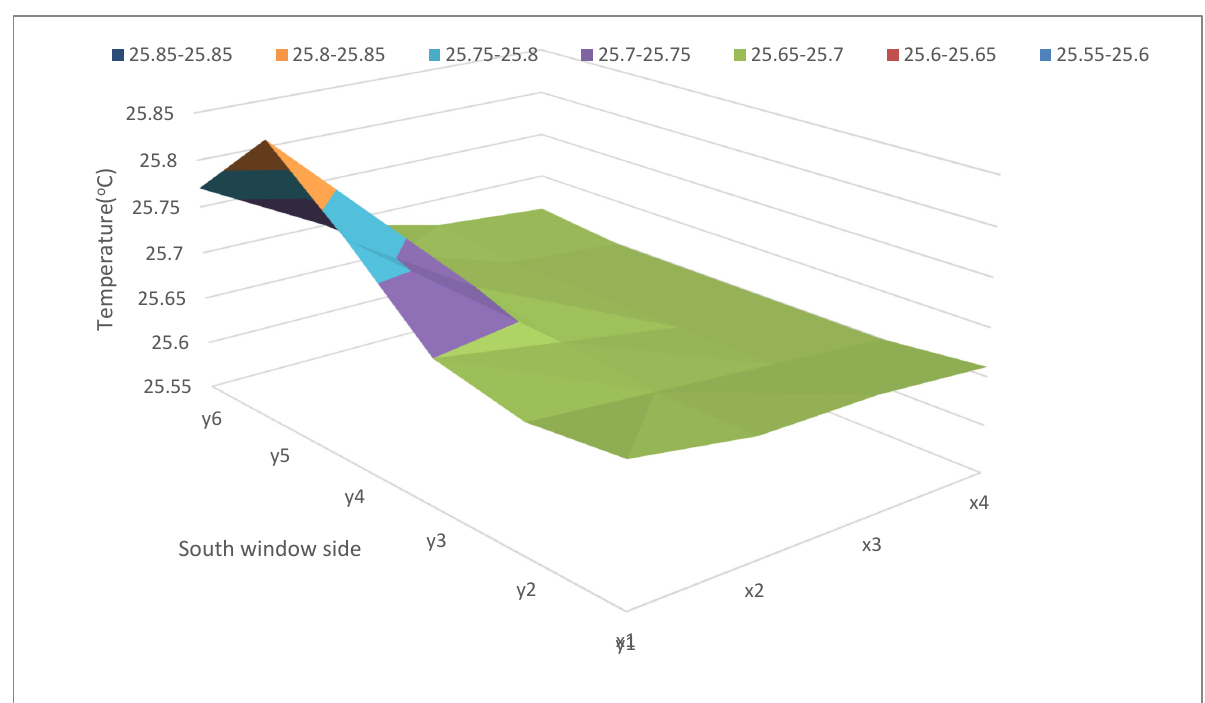
Figure 9. Operative temperature distribution for the radiant floor cooling space for the house (7 August, p.m. 12:51; Outdoor air temperature: 36.1 °C).